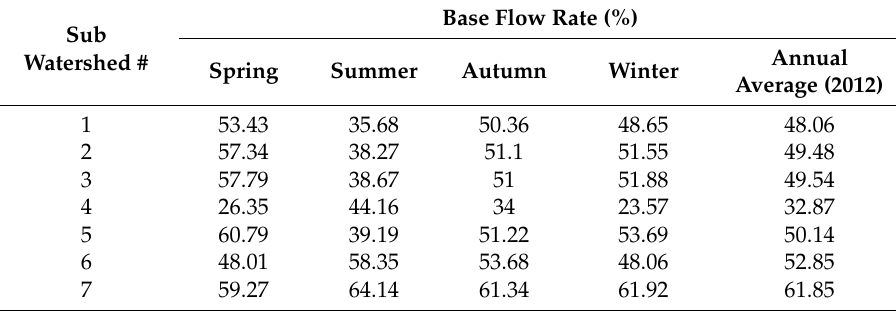
Table 6. Seasonal and annual average base flow rates for WSG 2.